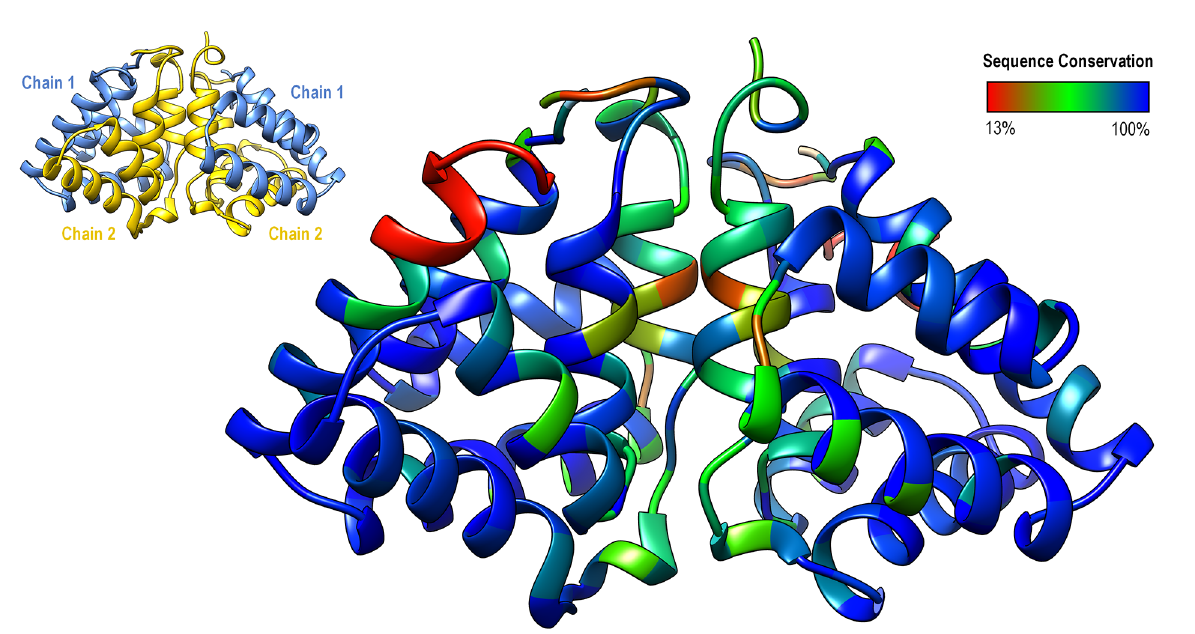
Figure 2. Sequence conservation mapped onto Fel d 1 structure. The information from sequence alignments (Figure 1) was used to locate tridimensionally the positions of greater amino acid conservation. Structure based on PDB ID: 2EJN [17]. A scheme indicating the orientation of each dimer in the tetramer (dimer- of-dimers) is also shown.